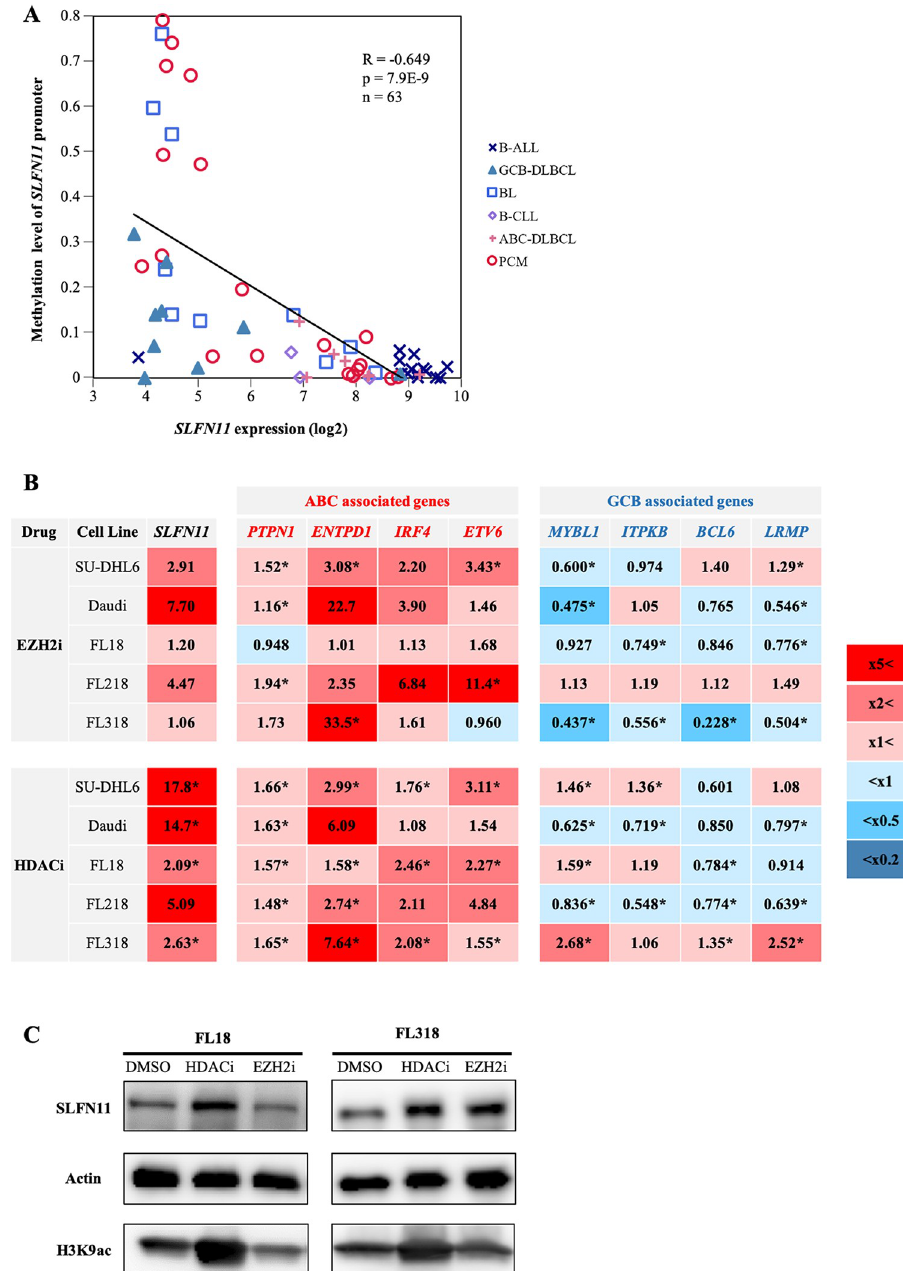
PLOS ONE | https://doi.org/10.1371/journal.pone.0237554 January 29,